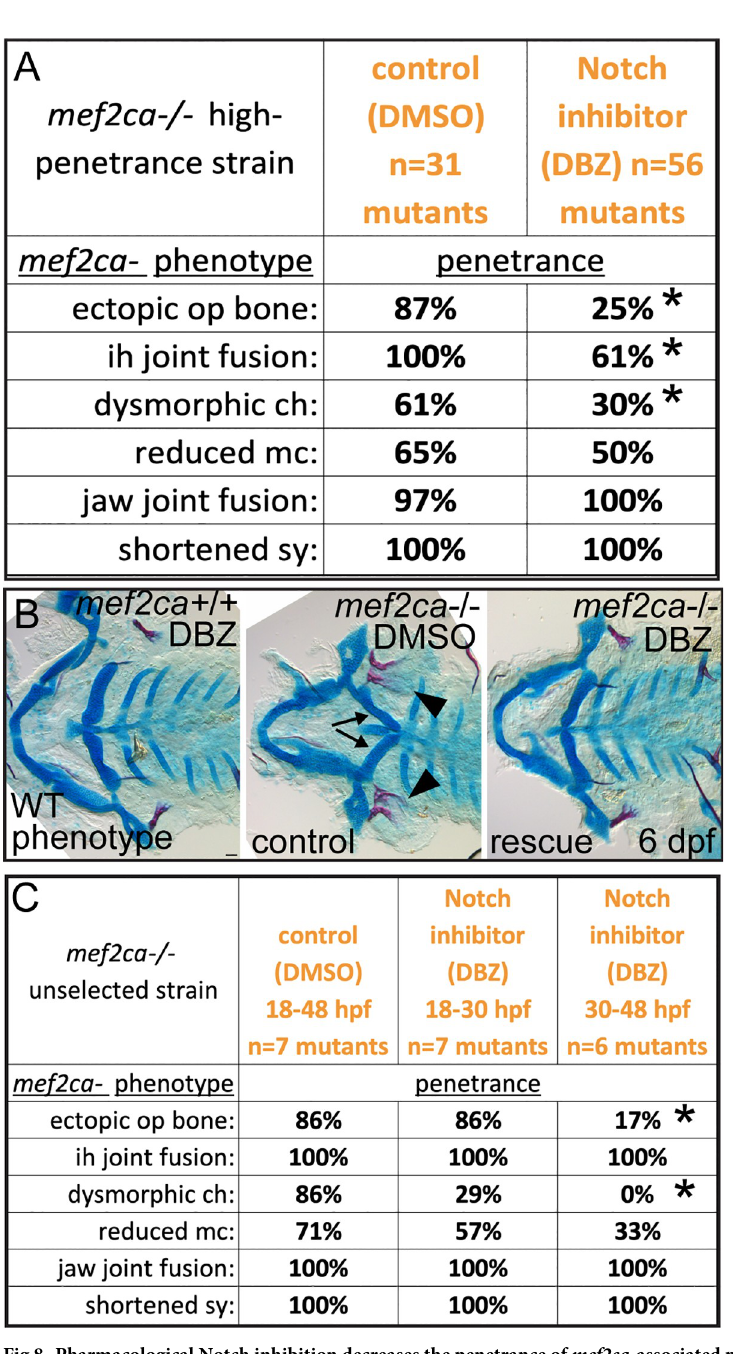
Fig 8. Pharmacological Notch inhibition decreases the penetrance of mef2ca -associated phenotypes without producing a skeletal phenotype in genetic wild types. (A) Animals heterozygous for mef2ca from the high- penetrance strain were intercrossed and offspring treated with Notch inhibitor (DBZ) or vehicle control (DMSO) from 18–48 hpf. Treated animals were fixed and stained with Alcian Blue (cartilage) and Alizarin Red (bone) at 6 dpf. Genotyped skeletal preparations were scored for penetrance of mef2ca -associated phenotypes. Asterisks indicate significance at alpha = 0.05 Fisher’s exact test compared with DMSO. (B) Imaged flat mounts of dissected skeletons from stained, genotyped animals treated with DMSO or DBZ were imaged. Arrows indicate dysmorphic ch and arrowheads mark ectopic bone. Scale bar: 50 μ m. (C) Animals heterozygous for mef2ca from an unselected strain were intercrossed and offspring treated with either DMSO from 18–48 hpf, or Notch inhibitor (DBZ) from 18–30, or DBZ from 30–48 hpf. Treated animals were fixed and stained with Alcian Blue (cartilage) and Alizarin Red (bone) at 6 dpf. Genotyped skeletal preparations were scored for penetrance of mef2ca -associated phenotypes. Asterisks indicate significance at alpha = 0.05 Fisher’s exact test compared with